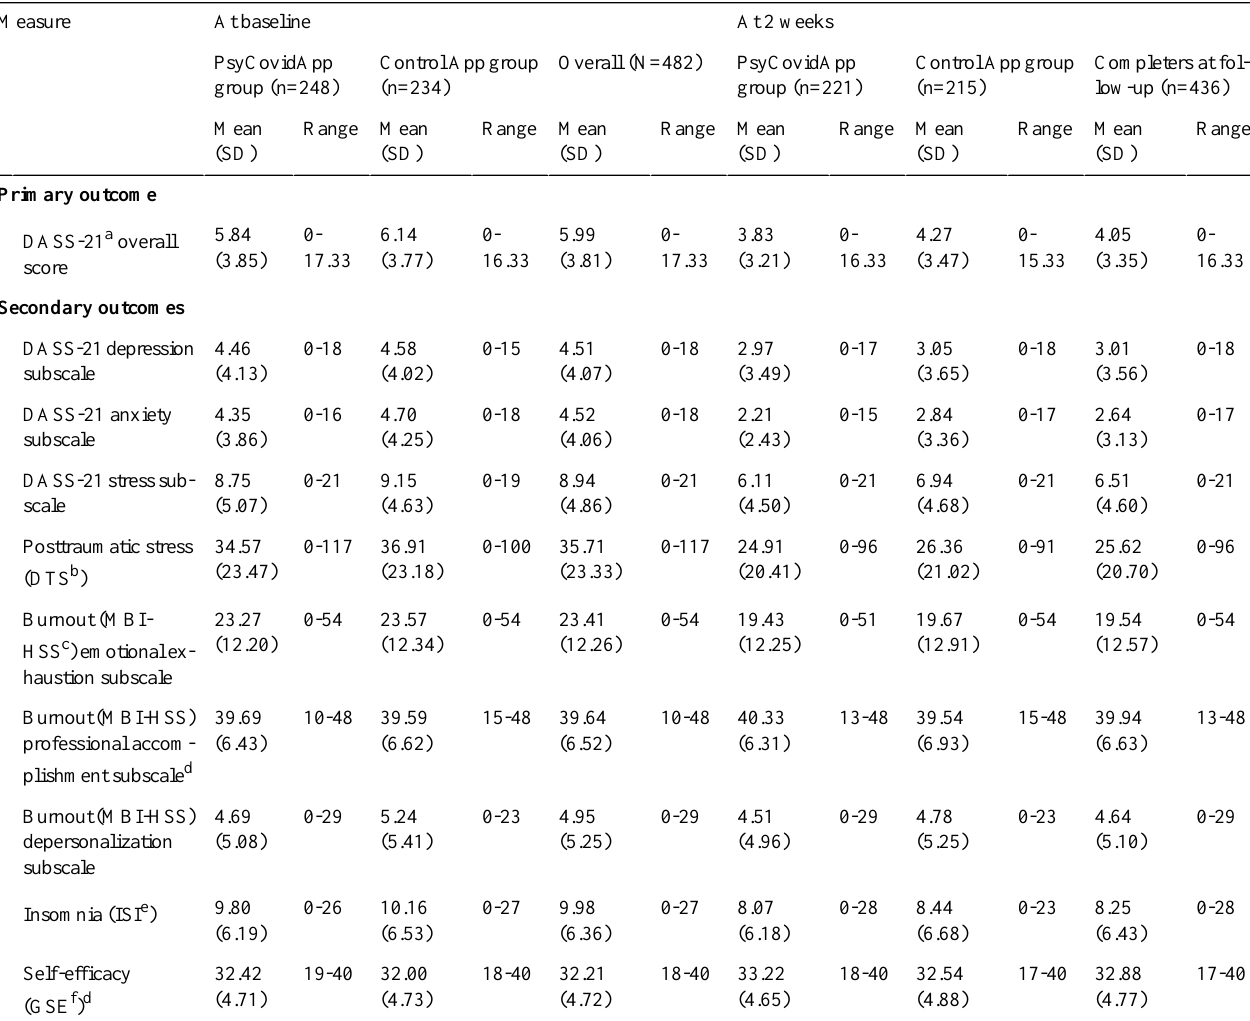
Table 3. Descriptive summaries of the primary and secondary outcome measures at baseline and 2 weeks for the PsyCovidApp and Control App groups.